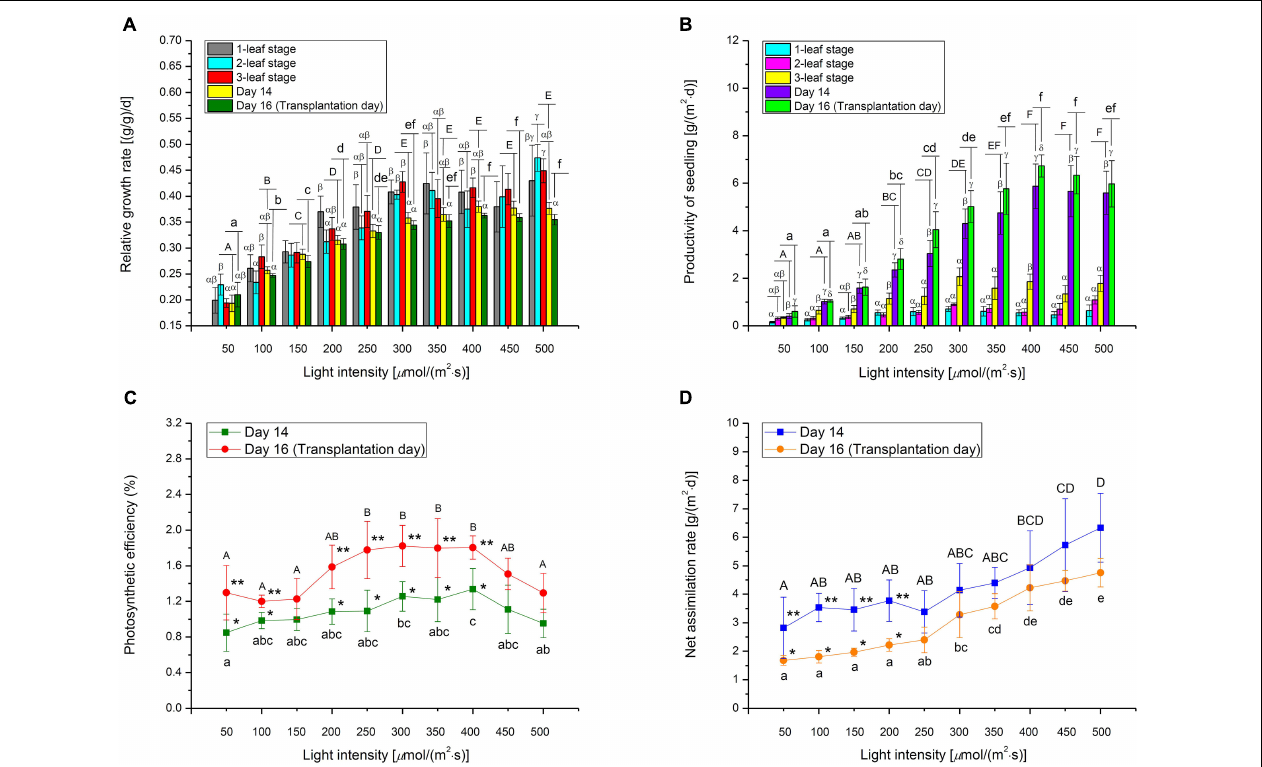
FIGURE 6 | (A) Relative growth rate, (B) Productivity, (C) Photosynthetic efficiency, and (D) Net assimilation rate of choy sum seedling grown under different white LED light intensities and growth stages and/or Day 14 and Day 16. Different Greek alphabets ( α , β , γ , and δ ) show significant differences among different growth stages, Day 14 and Day 16 under the same light intensity. Different upper cases (A, B, C, D, E, and F) and lower cases (a, b, c, d, e, and f) indicated significant differences among all the light intensities tested on Day 14 and Day 16, respectively ( n = 6, one-way ANOVA; Tukey multiple comparison; p < 0.05). The asterisks (* and **) indicate significant differences between Day 14 and Day 16 ( n = 6, Student’s t test, p <